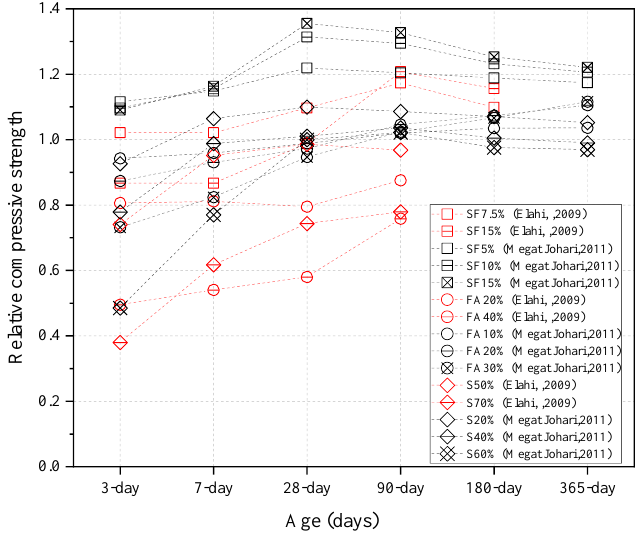
Figure 16. The relative compressive strength of concrete made with different SCMs: Silica Fume (SF), Fly Ash (FA), and Slag (S) vs curing ages [26,90].